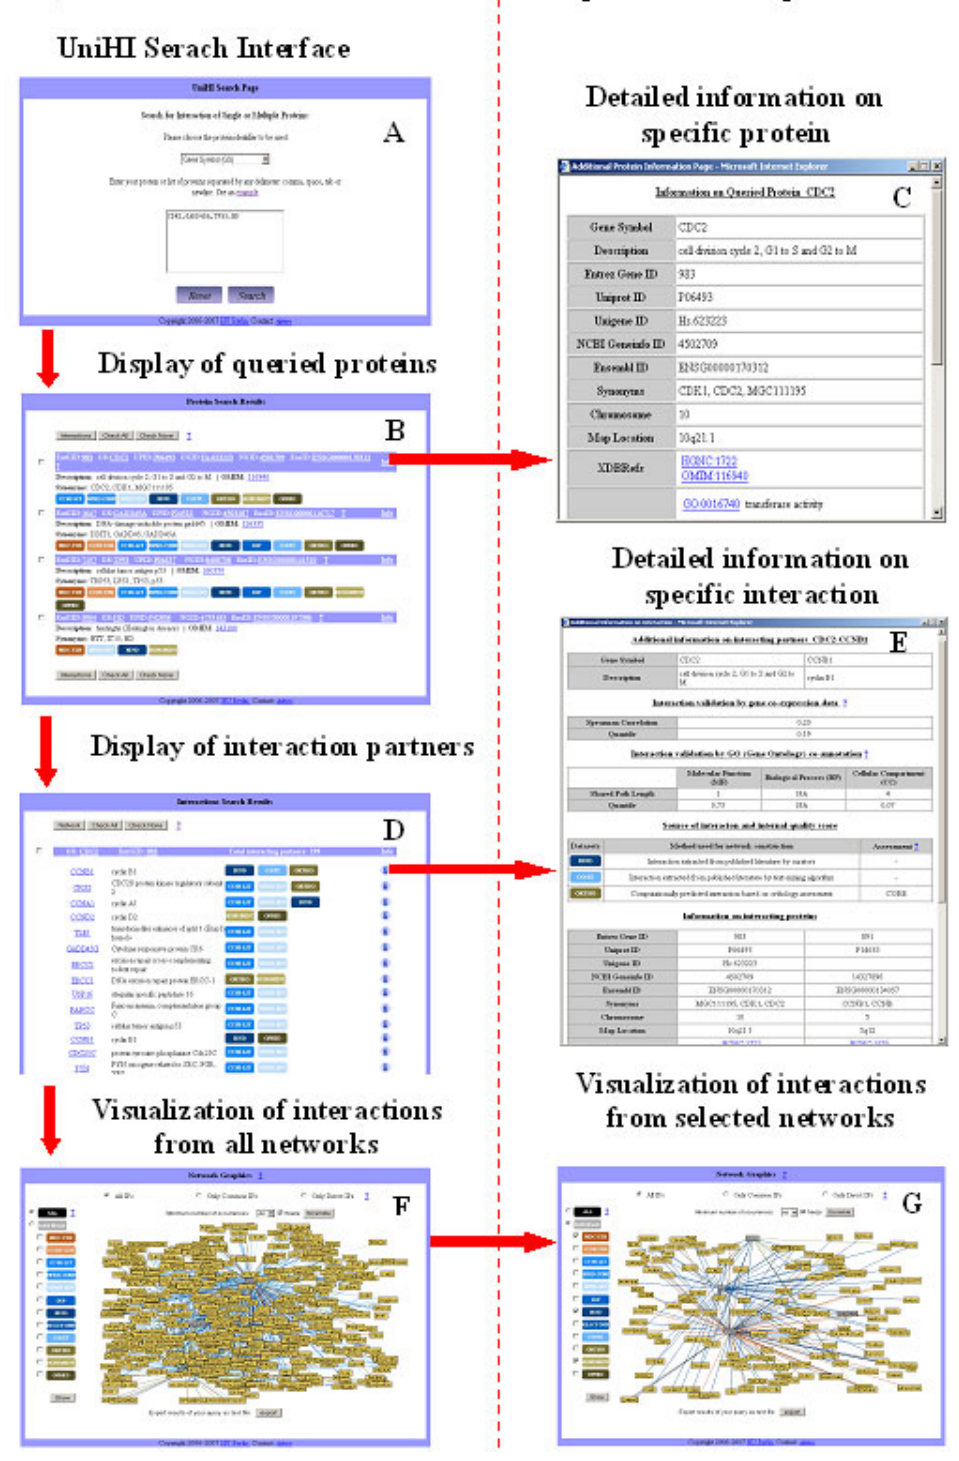
Figure 3: The workflow of the UniHI database can be divided into two layers: i) sequence of the main search (windows A, B, D and F); and ii) sequence of the optional search (windows C, E and G). This is illustrated here using the following exemplary set of proteins: CDK1,